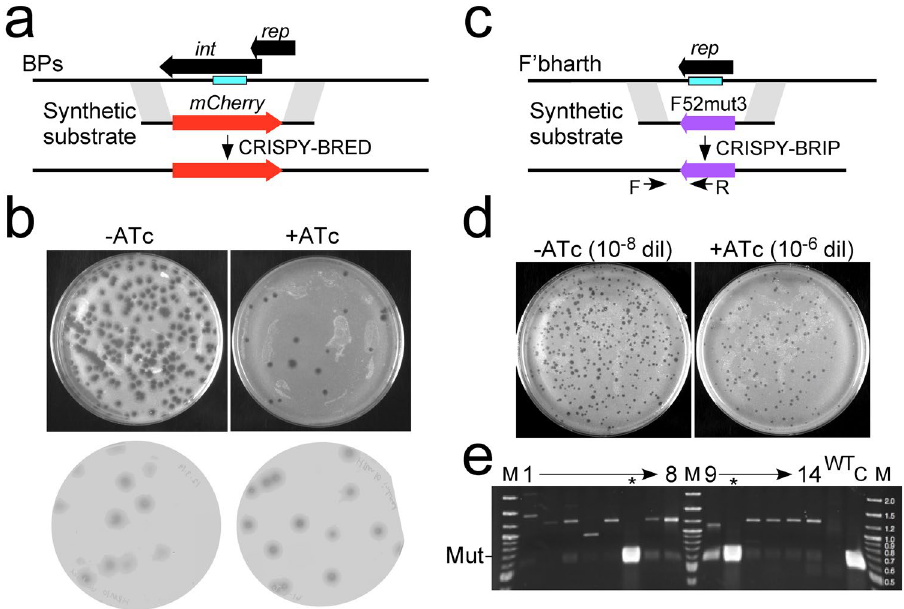
Figure 2. Construction of engineered phages. ( a ) Scheme for constructing an mCherry reporter derivative of phage BPs. A synthetic substrate containing the mCherry gene and sequences flanking the BPs integrase- repressor ( int - rep ) was designed to replace the int - rep region. The blue box indicates the position of the protospacer and PAM site to which a sgRNA was designed. ( b ) Primary plaques (top) were recovered with (+ ATc) or without (-ATc) inducer following co-electroporation of the synthetic DNA substrate and phage BPs genomic DNA into M. smegmatis recombineering cells and plated with M. smegmatis psgRNA cells (see Fig. 1). Fluorescent images of the plaques (bottom) show similar numbers of mCherry recombinants (dark plaques) in the presence (+ ATc) or absence (−ATc) of inducer, but these represent > 90% of all plaques recovered when the sgRNA is expressed (+ ATc). ( c ) CRISPY-BRIP engineering, illustrated by construction of a recombinant Fionnbharth phage carrying Fruitloop 52 mut3 (F 52 mut3). A synthetic substrate containing Fruitloop 52 mut3 (F 52 mut3) and sequences flanking the repressor ( rep ) gene of Fionnbharth (F’bharth) was constructed such as to replace the Fionnbharth repressor gene. The blue box indicates the position of the protospacer and PAM site to which a sgRNA was designed. ( d ) Primary plaques were recovered with (+ ATc) or without (-ATc) inducer following electroporation of the synthetic DNA substrate into M. smegmatis recombineering cells, followed by infection of Fionnbharth particles, incubation to allow a round of lytic growth, and plating with M. smegmatis psgRNA cells (see Fig. 1); samples were diluted 10 8 -fold or 10 6 -fold and plated with or without ATc, respectively. ( e ) PCR of 14 plaques from the + ATc plate using forward and reverse primers (F and R, panel c ) primers identified two recombinant plaques (asterisks); wild type phage (wt) and control (C) DNAs are shown. Original gel images are shown in Supplementary Fig.